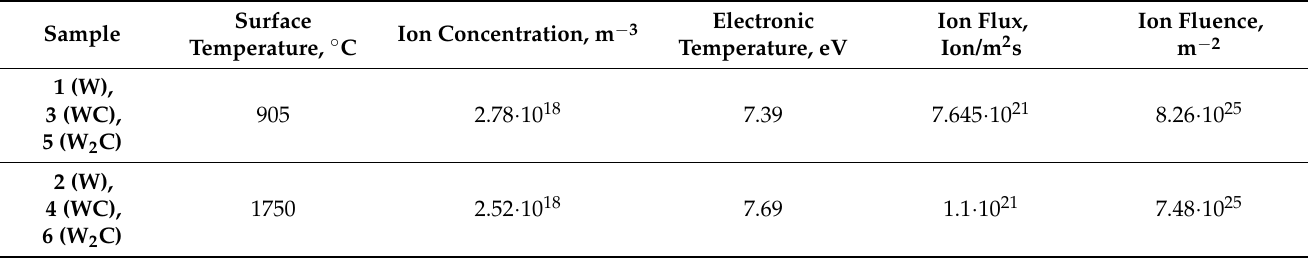
Table 2. Parameters of helium plasma depending on irradiation